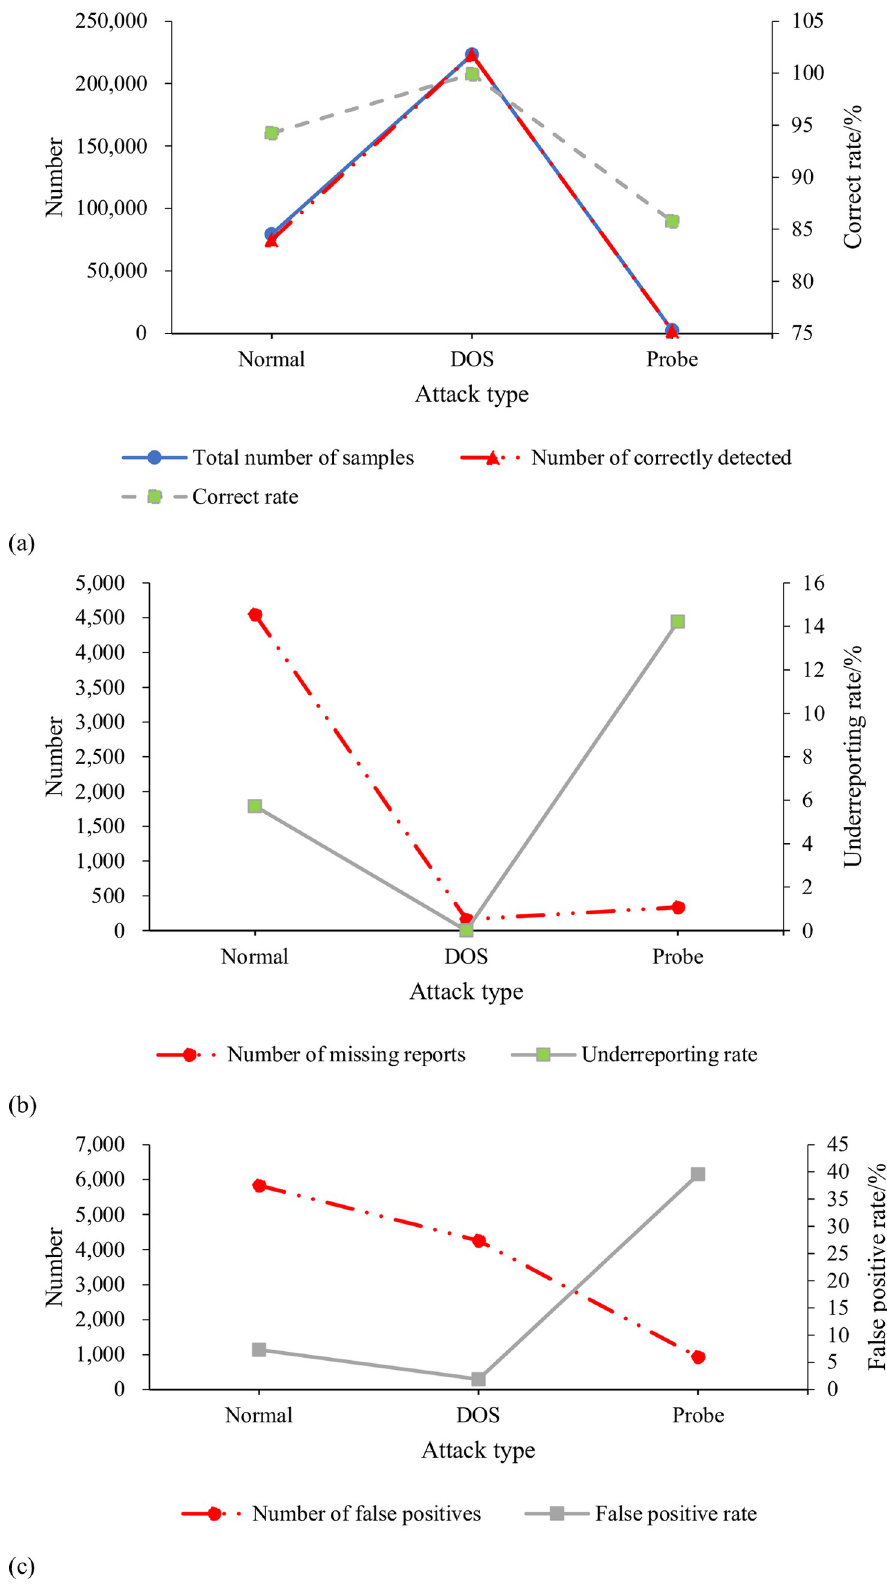
Fig 8. Test results of NAD model (a. CDR; b. UR; c. FPR).